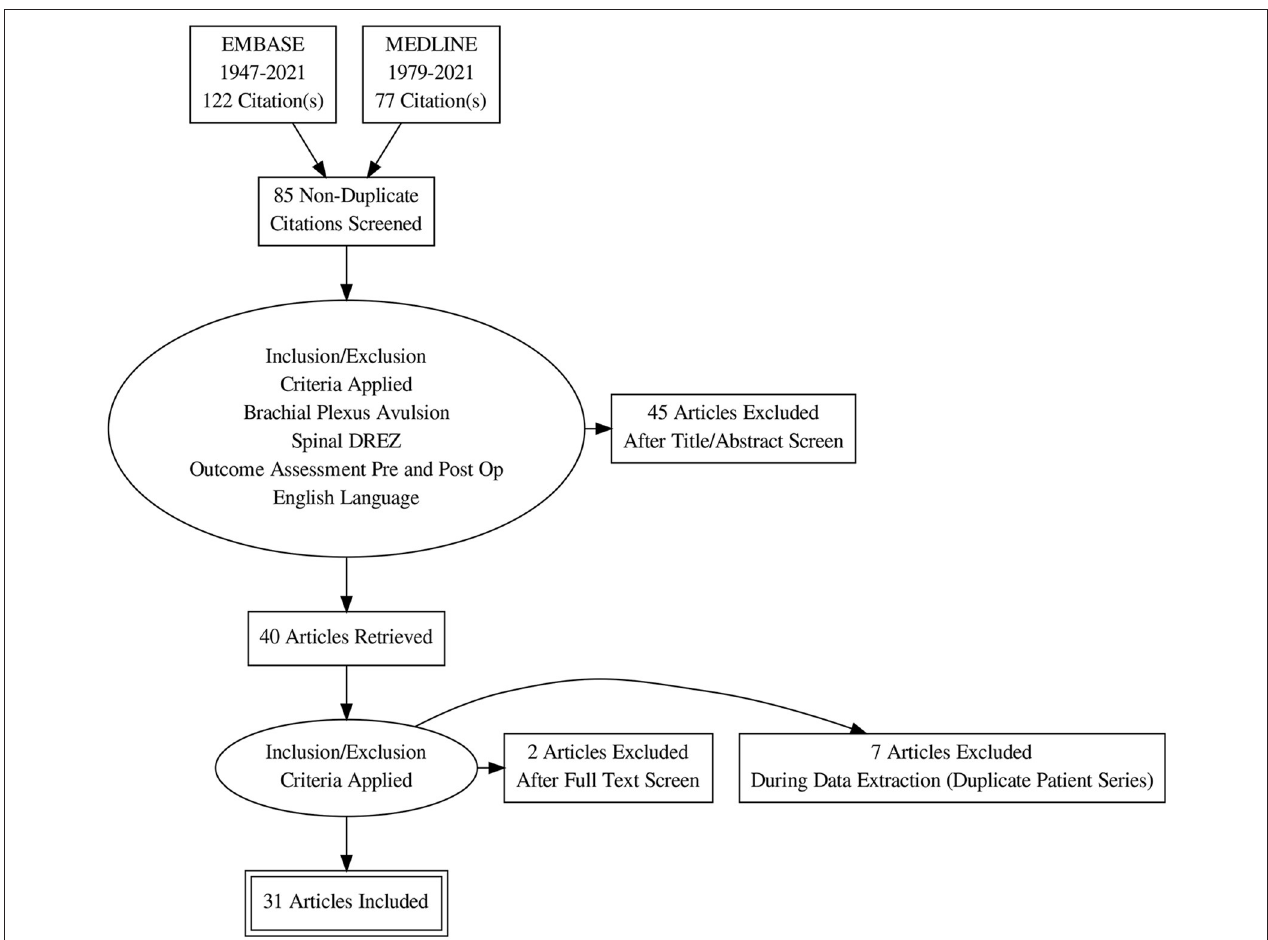
FIGURE 1 | PRISMA summary of systematic